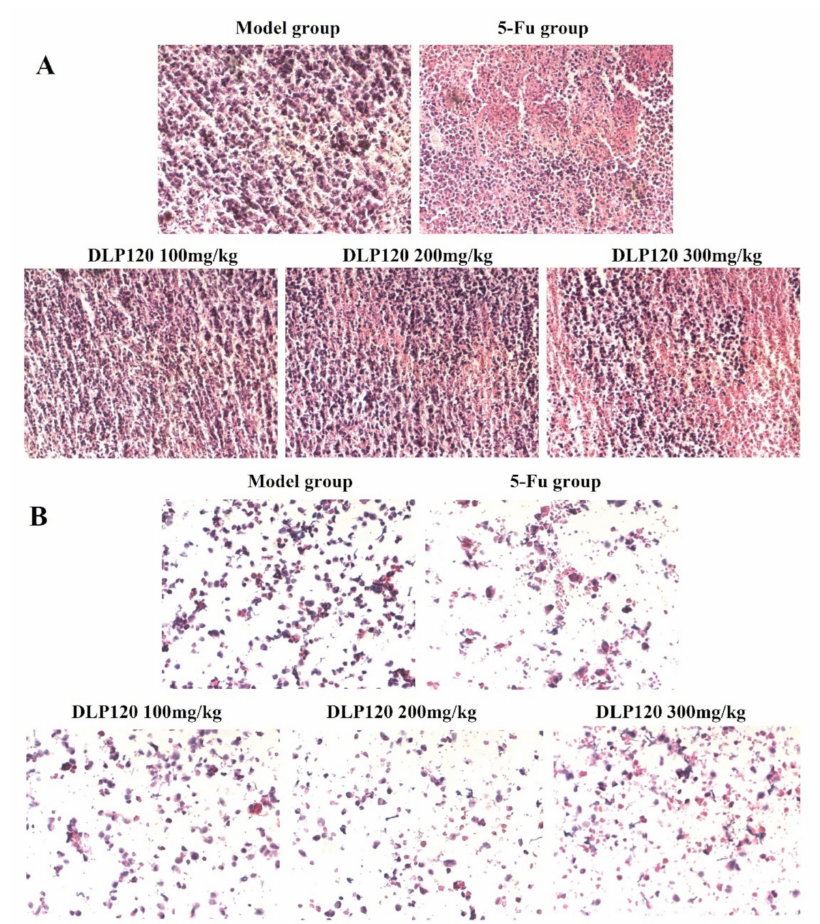
Figure 5. HE staining of slices of H22 tumor tissue ( A ) and tumor cells ( B